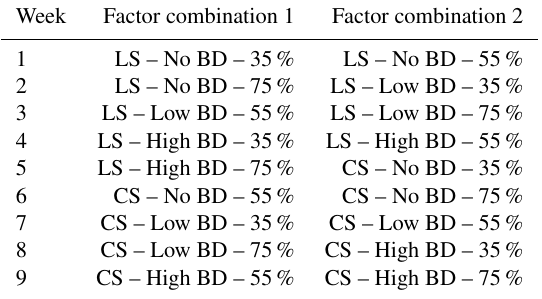
Table 3. Chronological order of the incubated factor combinations. Two different factor combinations with their respective repetitions ( n = 3) were placed together for each weekly incubation course (see Fig. 1). The factors were combined by (1) soil (loamy sand: LS,